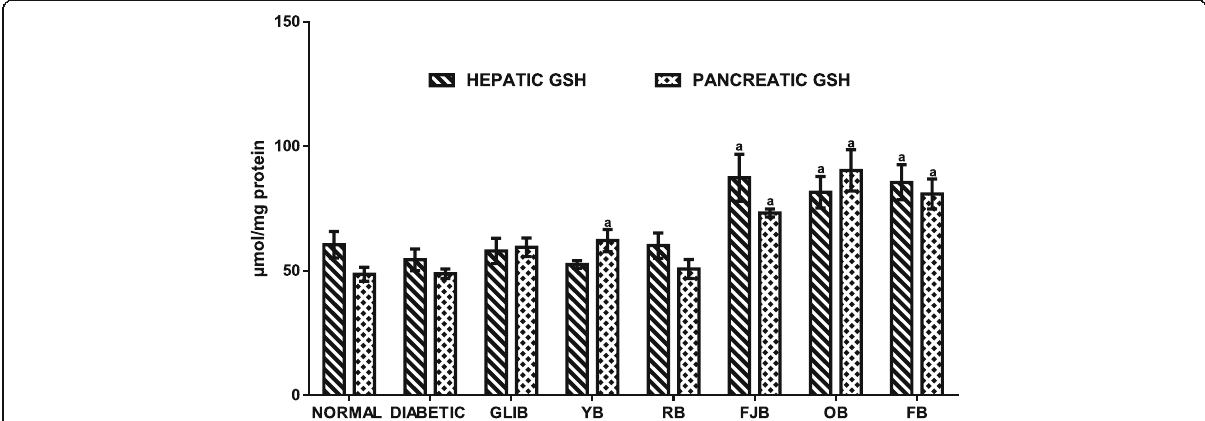
Fig. 6 effects of polyherbals on hepatic and pancreatic reduced glutathione (GSH) levels in normal and diabetic rats. Results represented as Mean ± S.E.M. n = 6. a p < 0.05 or b < 0.001 different from control normal CMC group. c p < 0.05 or d < 0.001 different from control